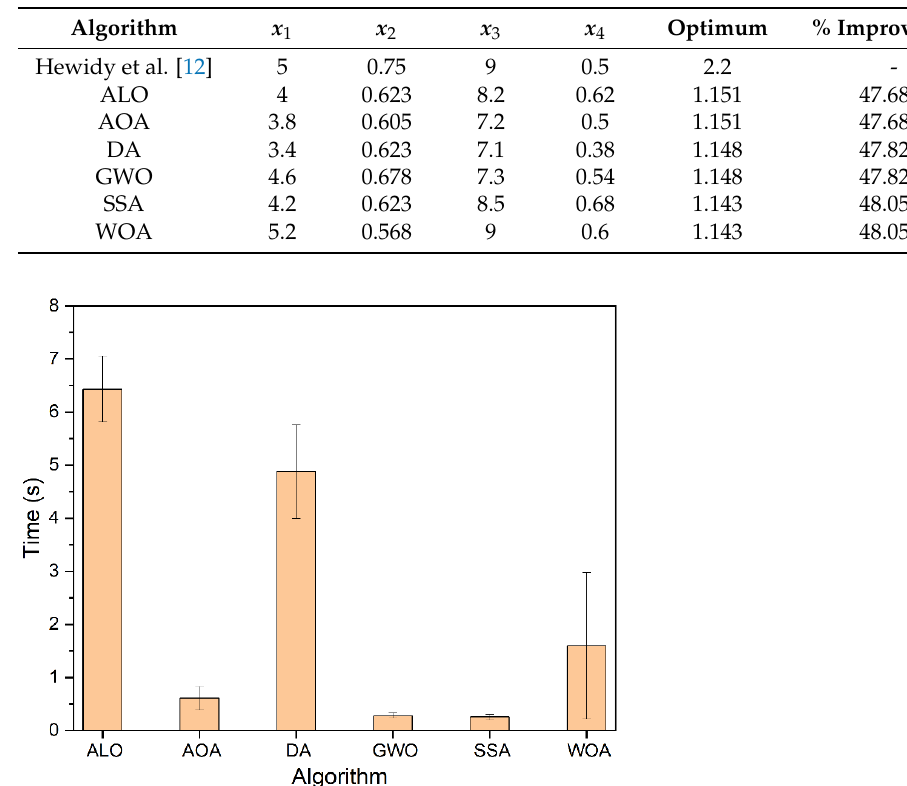
Table 5. Comparison of current results with solutions from the literature for SR optimization.